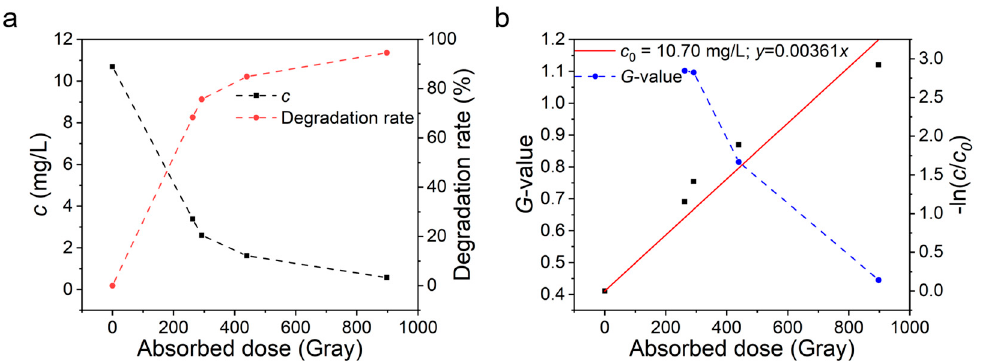
Figure 2. Effect of absorbed dose on SMZ degradation (energy = 80 keV; beam current = 1 mA; initial SMZ = 10.70 mg/L; pH = 3.5): ( a ) Concentration change and degradation rate diagram of SMZ; ( b ) G-value variation and kinetic fitting.